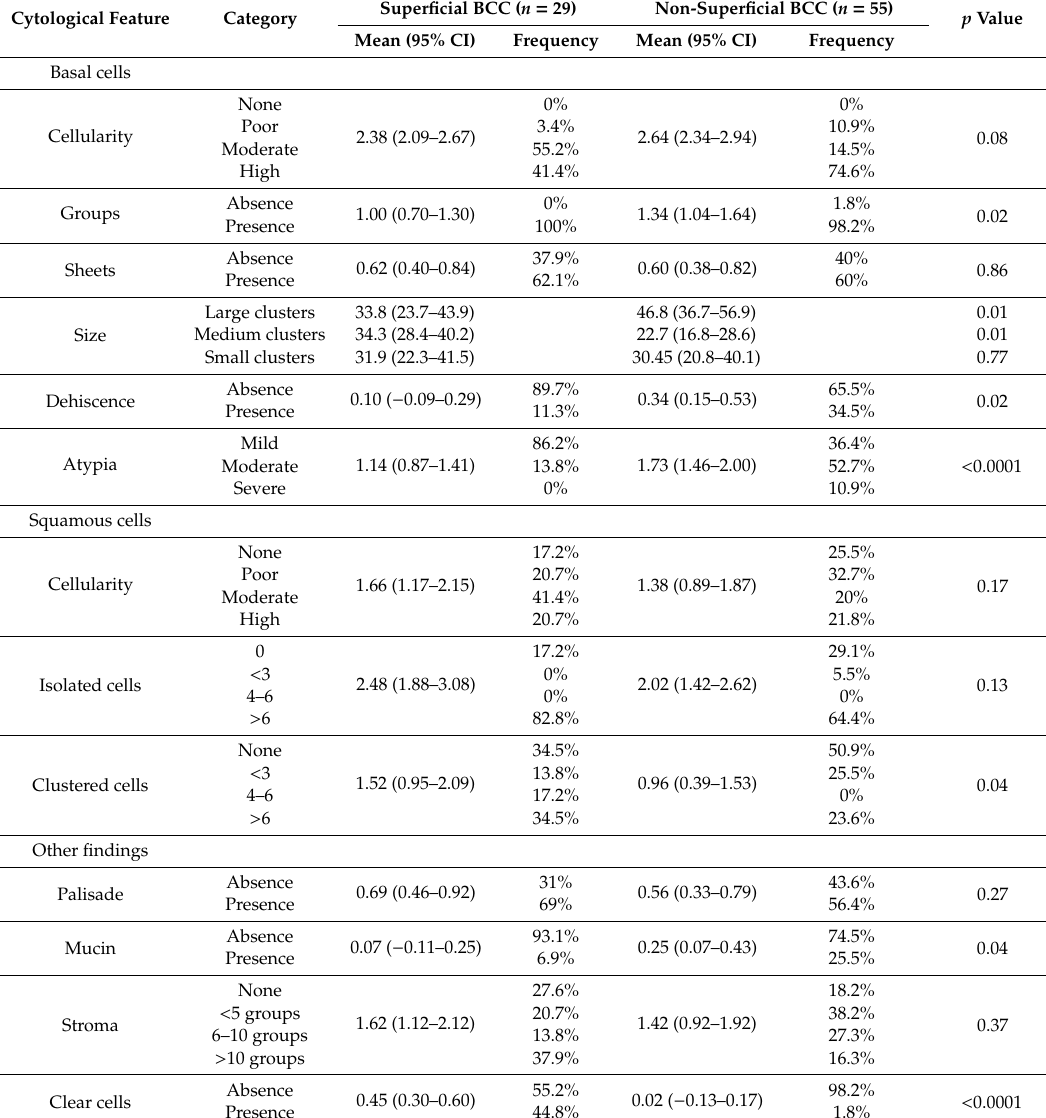
Table 2. Cytological findings and distribution scores in superficial and non-superficial basal cell carcinoma (BCC).